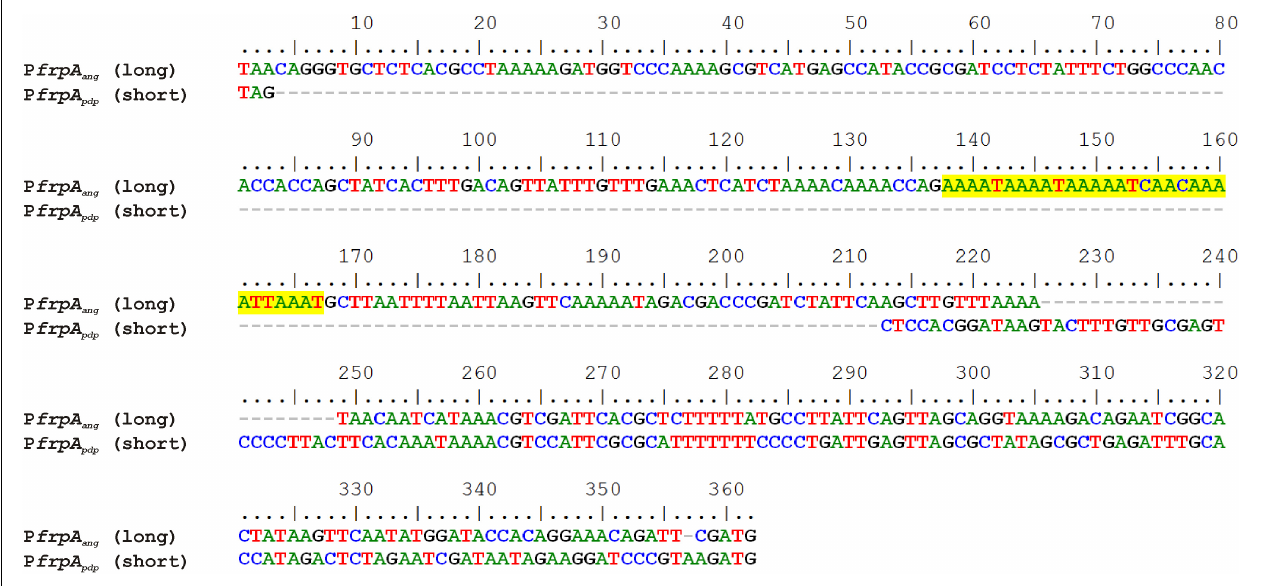
FIGURE 7 | Alignment of a long and a short pbtB - frpA intergenic region (between pbtB stop codon and frpA ATG start codon) containing frpA promoter of V. anguillarum (P frpA ang ) and P. damselae subsp. piscicida (P frpA pdp ). Low complexity AAAAT repeat motifs are highlighted in